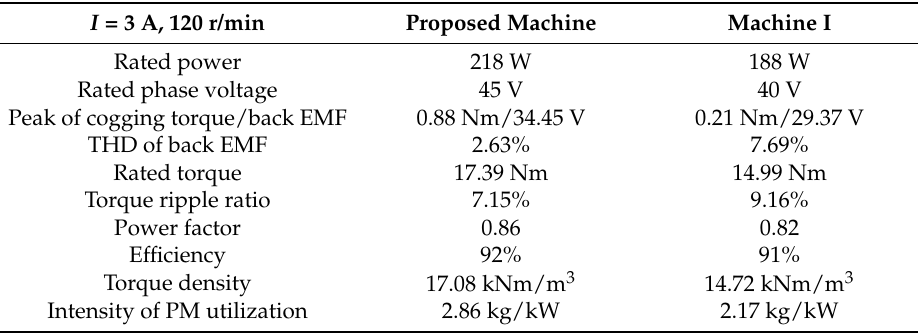
Figure 19. Loss comparison when two machines rotate at 120 r/min ( I = 3 A): ( a ) Proposed machine; ( b ) Machine I. Table 7. Comparison results of the two machines.